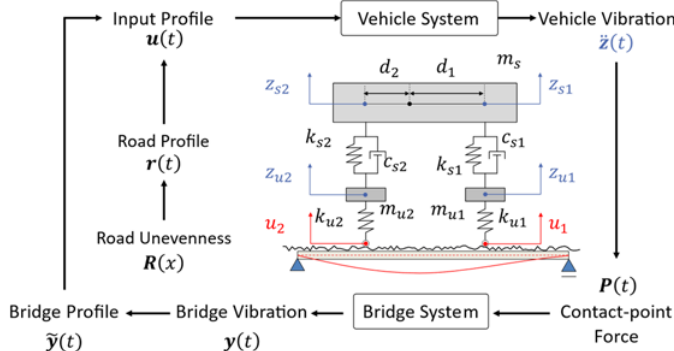
Figure 2. Conceptual diagram of vehicle–bridge interaction [9] .